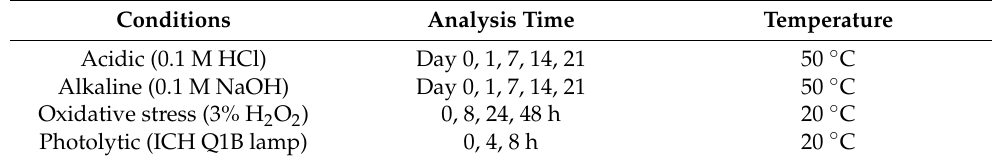
Table 2. Forced degradation